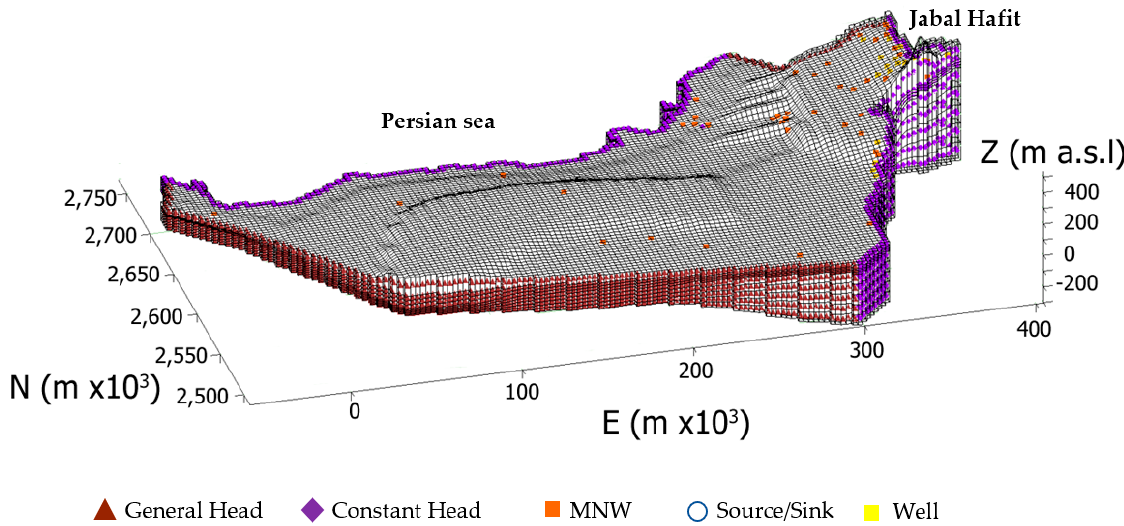
Figure 2. Conceptualized hydrogeological model of Abu Dhabi aquifer.